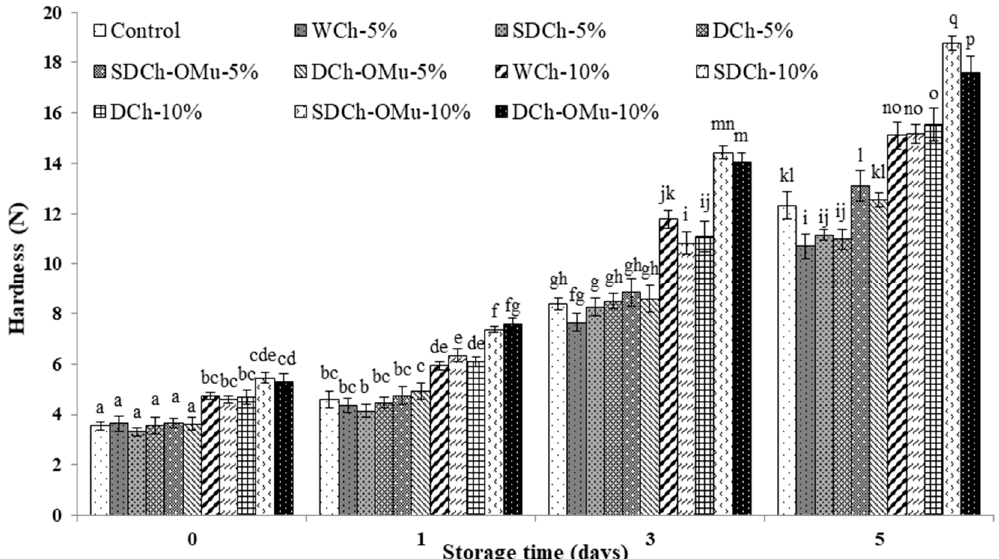
Figure 3. Hardness of breads formulated with different types and levels of chia flour during storage at 24 ± 2 °C. Values are the mean of three independent batches (n = 3) and vertical bars indicate standard deviation. WCh: Whole chia flour; SDCh: semi-defatted chia flour with mucilage; DCh: defatted chia flour with mucilage; SDCh-OMu: semi-defatted chia flour without mucilage; DCh-OMu: defatted chia flour without mucilage. ). Bars followed by different letters differ at p < 0.05, according to Tukey test. There were no significant di ff erences in springiness between the samples of fresh bread or between samples during storage time (data not